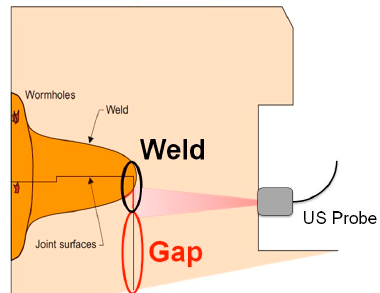
Figure 14. Ultrasonic investigation of the internal gap between lid and canister after friction stir welding.